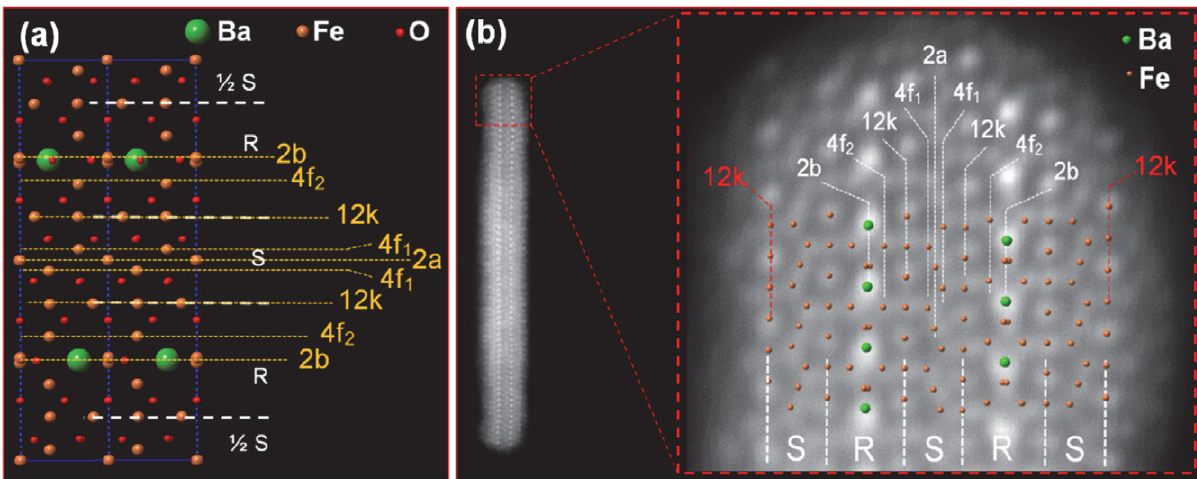
Figure 2. A schematic representation of the magnetoplumbite structure (a) and HAADF STEM image of a hexaferrite nanoplatelet oriented along <10- the 1 0> direction of its magnetoplumbite structure (b). In image (b) the projected magnetoplumbite structure is superimposed to illustrate the positions of the Ba 2+ and Fe 3+ columns. Different Fe lattice sites (trigonal 2b, tetrahedral 4f 1 , octahedral 12k, 2a, and 4f 2 ) are marked. ( Reproduced from the publication 44 by D. Makovec, M. Komelj, G. Dražić, B. Belec, T. Goršak, S. Gyergyek, D. Lisjak, Acta Mater. 2019 , 172, 84–91 under the terms of CC BY 4.0 license